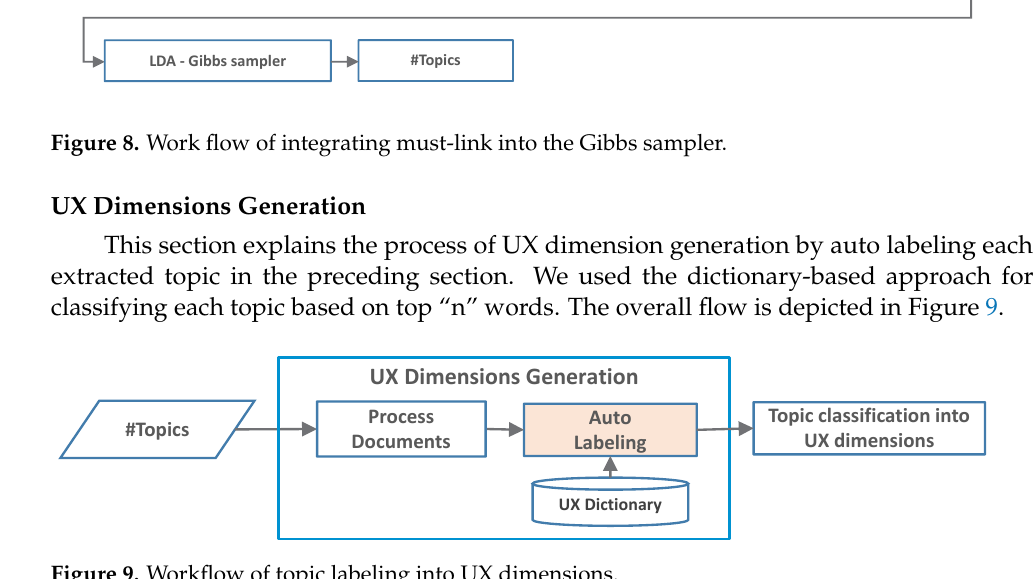
Figure 9. Workflow of topic labeling into UX